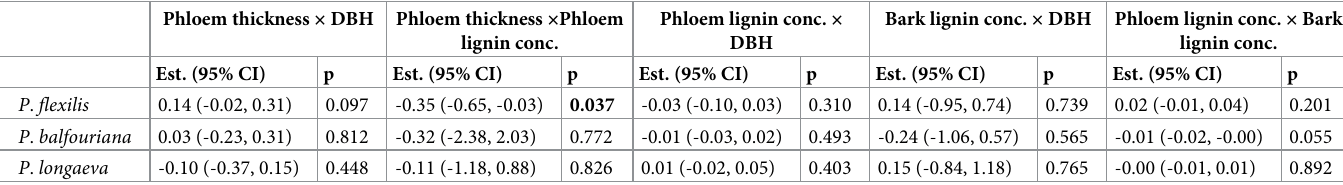
Effect size (Est.) and 95% confidence interval (95% CI) estimates between comparison samples are shown. P-values (p) presented describe the likelihood of statistical difference with values < 0.05 presented in